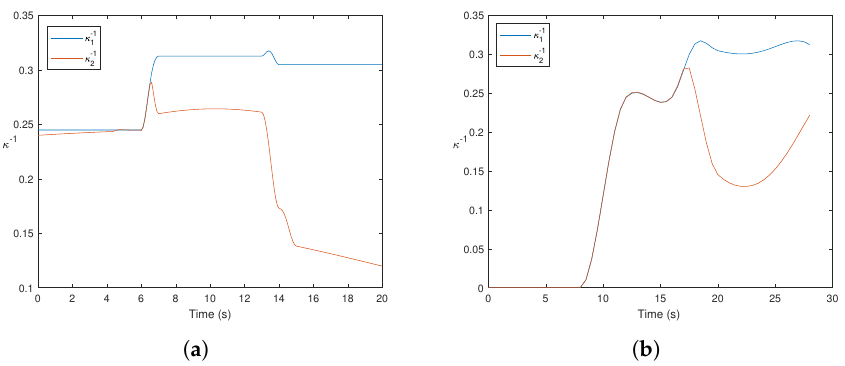
Figure 13. Inverse condition index of Hybrid Mechanisms 1 and 2: ( a ) oscillation trajectory and ( b ) reduction